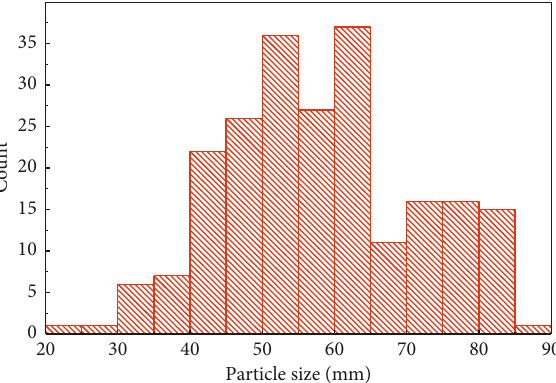
Figure 3: Equivalent size distribution of magnetite